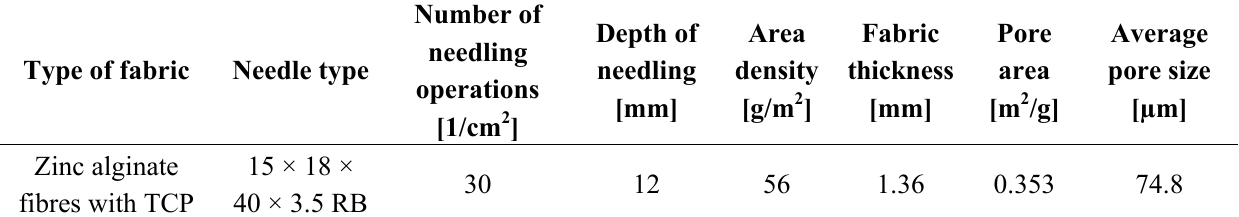
Table 2. Conditions for the production of nonwoven fabric from alginate fibres and properties of the fabric.